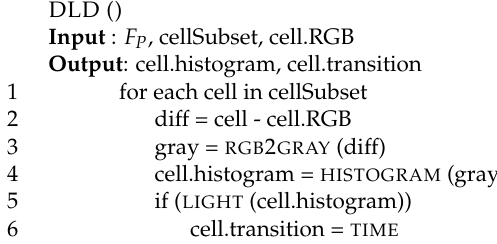
Figure 7. Dynamic luminosity: function